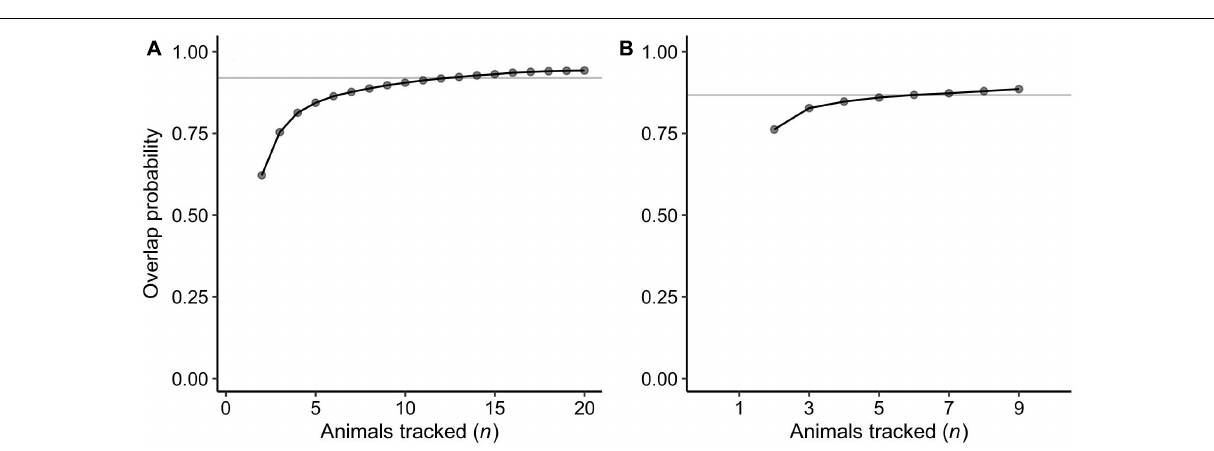
FIGURE 4 | Results of the overlap probability analysis to assess adequacy of the sample sizes ( n = the number of animals tracked) to describe the general inter-nesting habitat distributions of the green turtles that nested at (A) Jazirat Mashabah and (B) Ras Al Baridi. Each point is the mean probability of an additional n th individual to be within the areas used by the previously tracked n-1 turtles. Curves are rational functions fitted to the means. Gray lines denote 95% of the estimated horizontal asymptotes and after this point sample size is deemed to be adequate (see Shimada et al.,